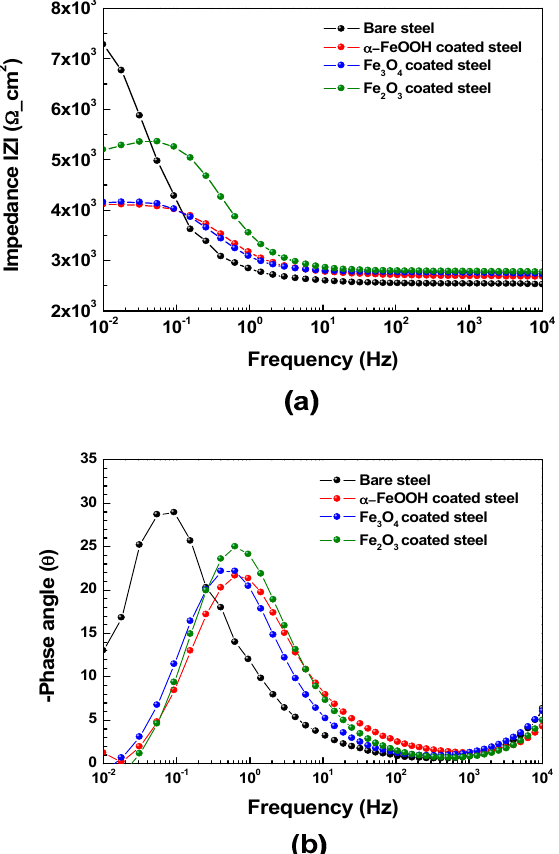
Figure 4. Bode plots of ( a ) impedance and ( b ) phase angle vs. frequency for specimens covered with different iron oxides ( α -FeOOH, Fe 3 O 4 , Fe 2 O 3 ) and uncovered after 6 h of immersion in the simulated district heating water at 40 °C.